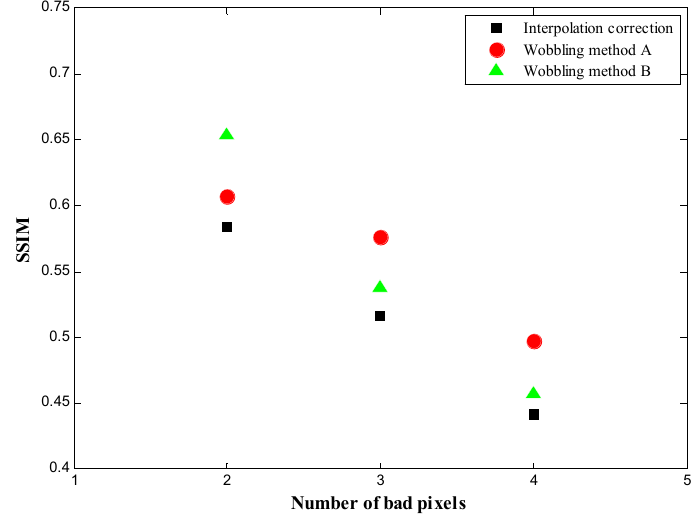
Figure 9. PSNR of different correction methods for various bad-pixel numbers.